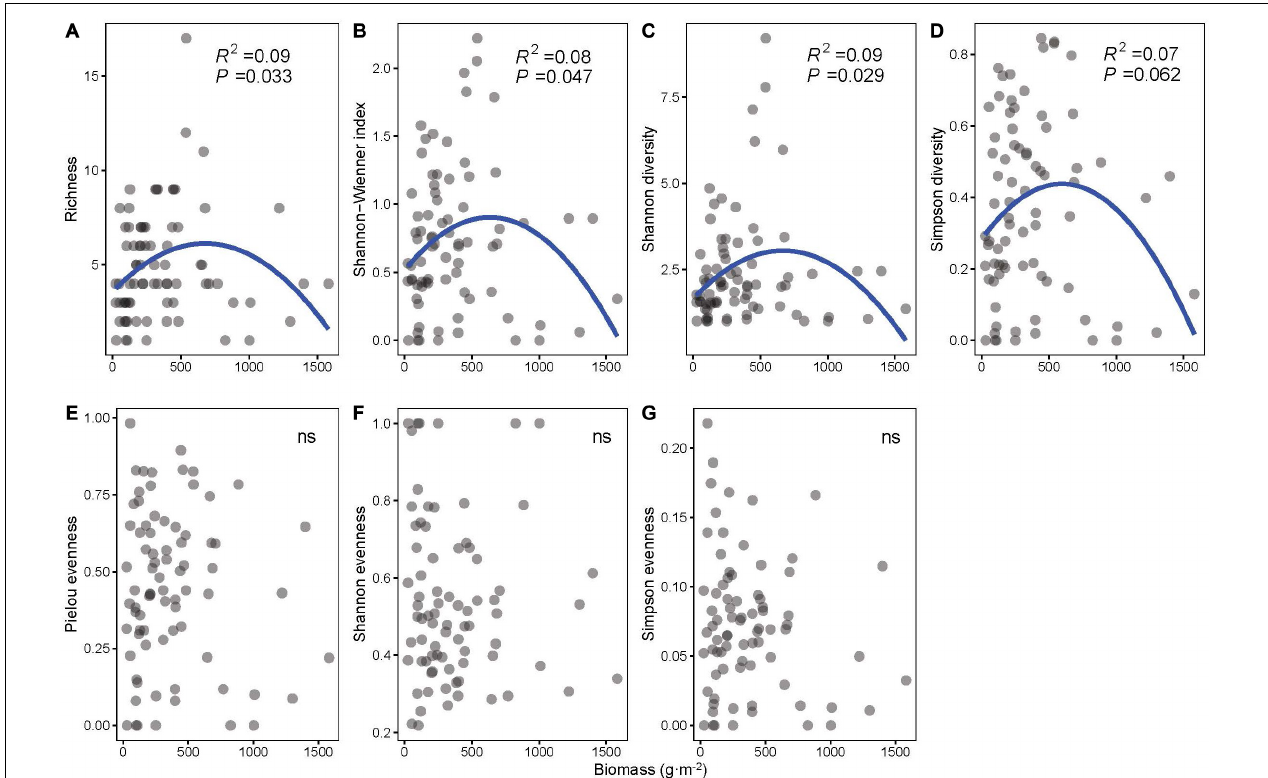
FIGURE 2 | The least-squares quadratic regressions between biomass and biodiversity indices: (A) richness, (B) Shannon–Wiener index, (C) Shannon diversity, (D) Simpson diversity, (E) Pielou evenness, (F) Shannon evenness, and (G) Simpson evenness ( n = 78).